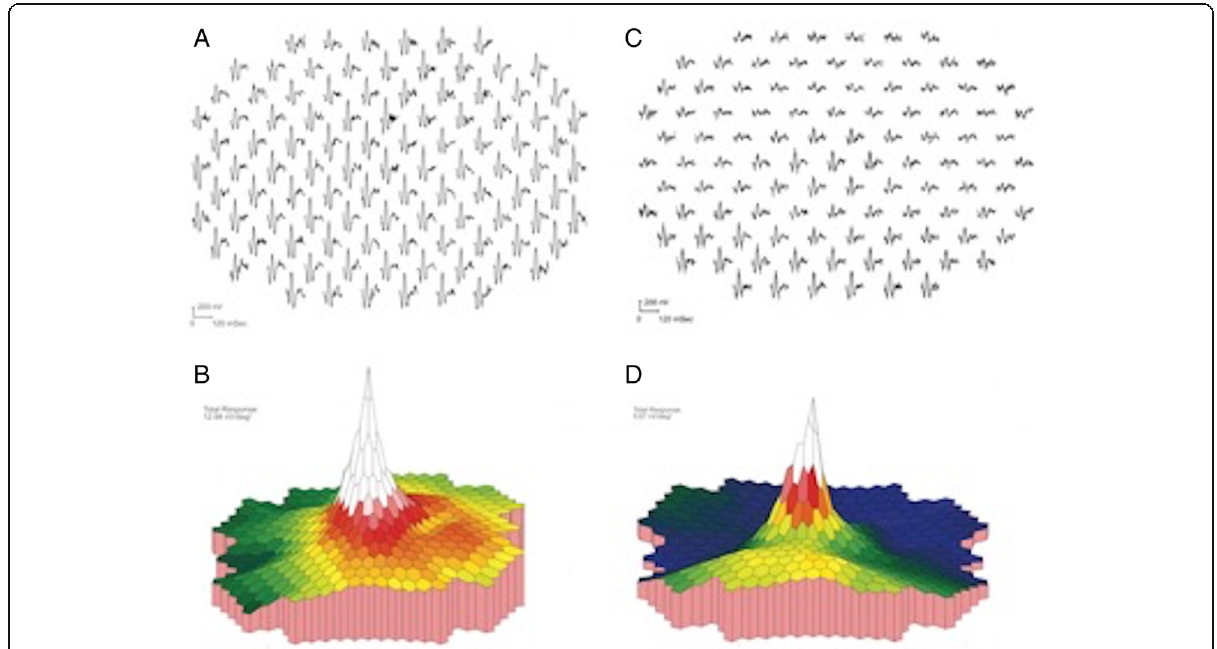
Fig. 5 a Multifocal ERG traces from the right eye showing normal amplitudes throughout macula. b Response density surface plot of the right eye mfERG showing normal peak at fovea and symmetric amplitude decrease with increasing eccentricity from the fovea. c mfERG traces from the left eye showing a depression in the superior field (inferior retina). d Response density surface of the left eye mfERG illustrating the relatively preserved foveal response with marked loss of amplitude in the superior field (patient 3)